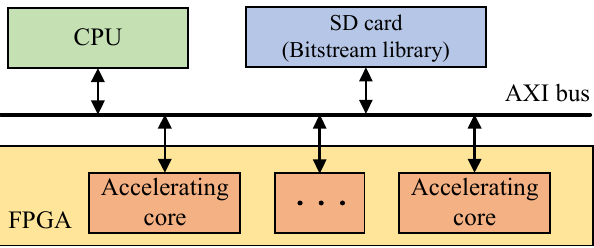
Figure 5: Overall architecture of the proposed password recovery accelerator.